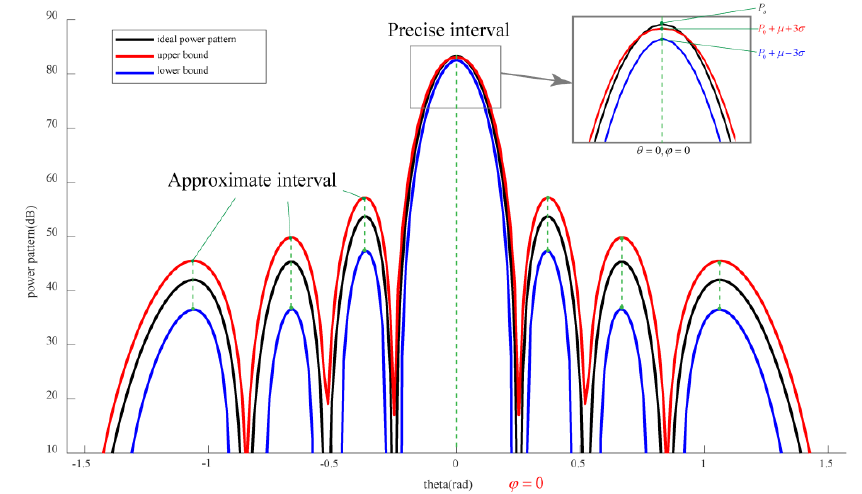
Figure 7. The interval of the power pattern of the 8 × 8 subarray with random geometric errors, the